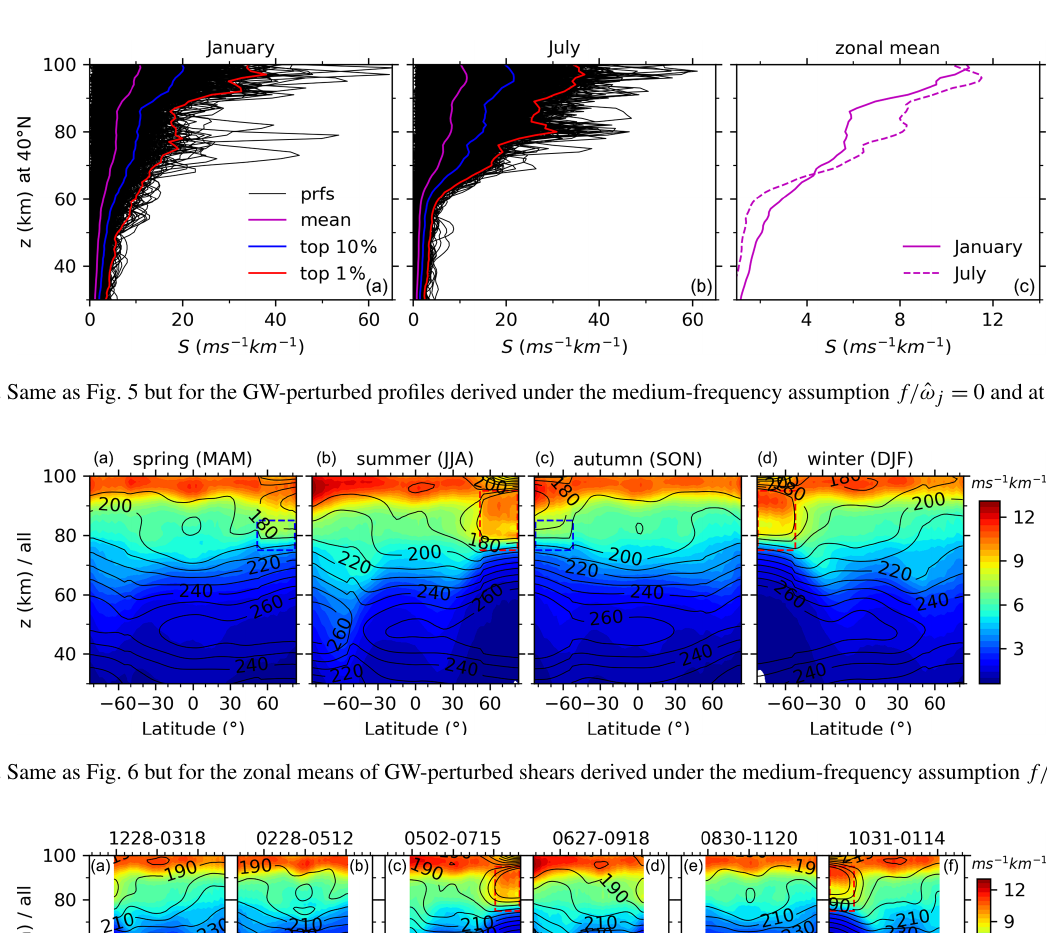
for f/ ˆ ω j (cid:54)= 0 but have slightly smaller magnitudes.